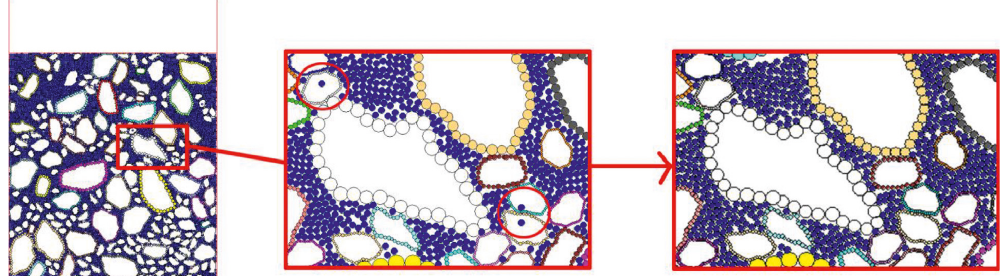
Figure 11: Escaped balls deletion before random voids modelling.